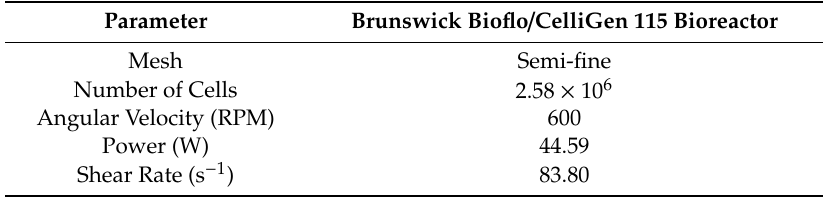
Table 5. Overall parameters of the Brunswick Bioflo / CelliGen 115 bioreactor mesh.